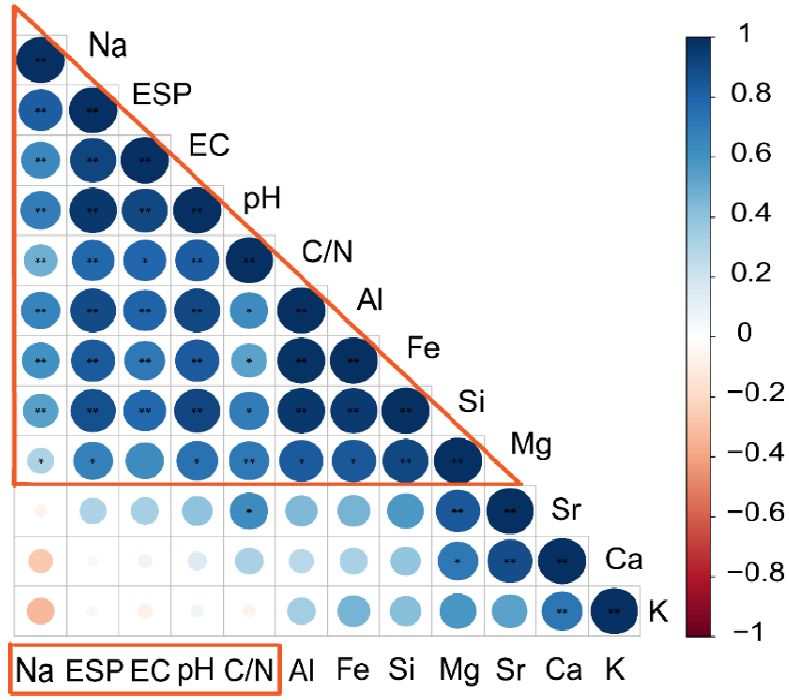
Figure 4. Pairwise comparisons of soil physicochemical properties (Spearman’s correlation coefficients).